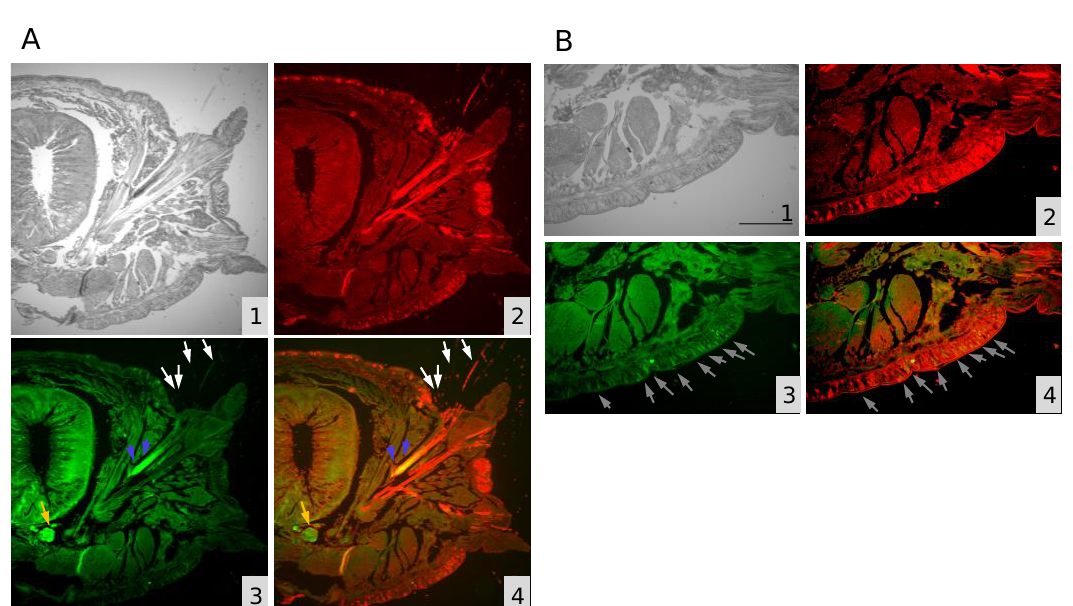
Figure 3. The localization patterns of PnL and Agaricus bisporus agglutinin (ABA)-lectin bindings. The Perinereis sp. tissues were 40 × ( A ) or 80 × ( B ) magnified, visualized with phase-contrast microscopy ( 1 ), anti-PnL detection by Alexa 488-conjugated antibody (red) ( 2 ), FITC-ABA lectin binding (green) ( 3 ), and a merging of both staining ( 4 ). The arrows indicate the superimposed detecting (yellow). Setae (white), acicula (blue), nerve cord (orange), and epidermis (gray) are shown. Scale bar: 300 μm ( B ).